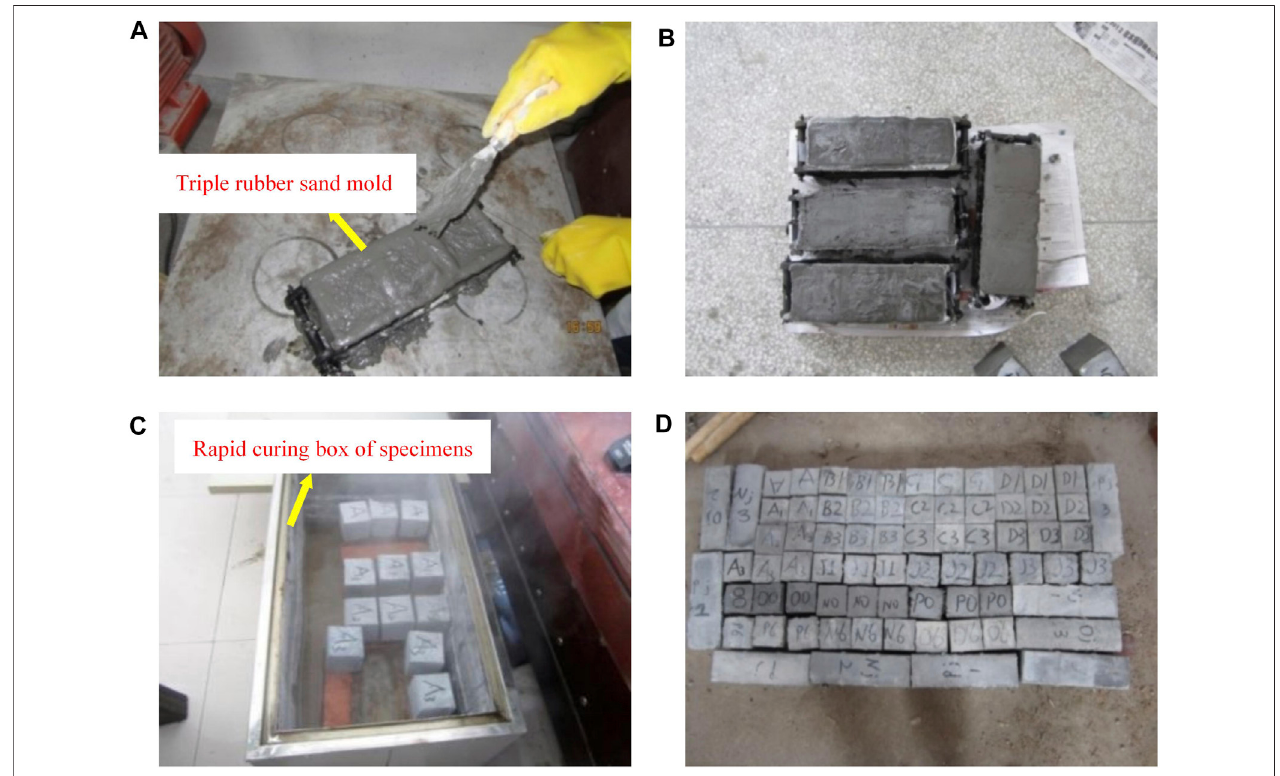
FIGURE 2 | Specimens production process; (A) concrete mold forming; (B) room temperature curing. (C) Rapid curing box of specimens. (D) Specimens.